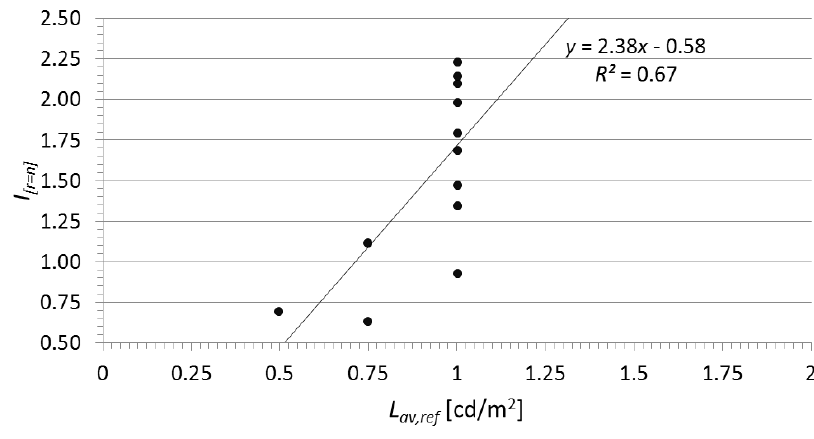
Figure 18. Scenario 3 (ideal case): correlation between I index and L av,ref .